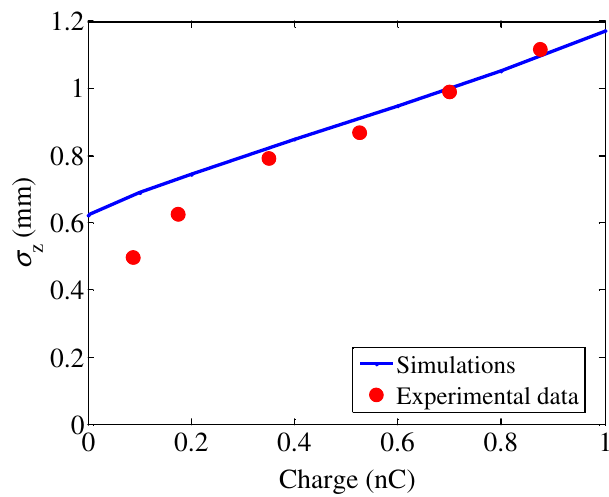
FIG. 36. (Color) Beam on the BC1 OTR screen with its large horizontal dispersion. The L1S rf phase is off crest by 25 (cid:9) . The first rf deflector is ON, and the X-band cavity is OFF at left, and ON (20 MV) at right, demonstrating proper X-band linearization of the energy